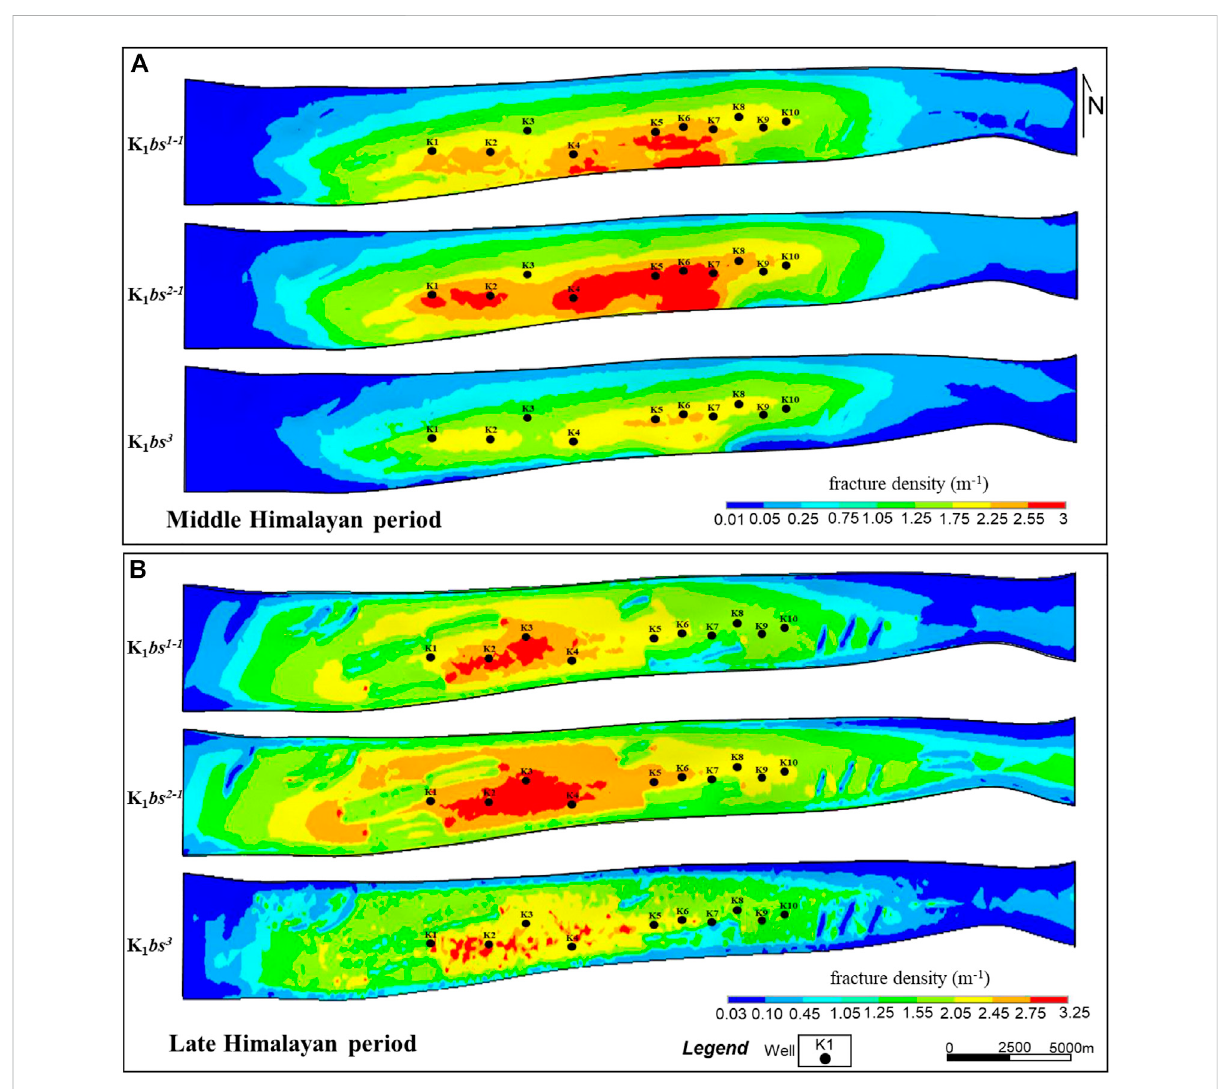
FIGURE 12 Spatial distribution offracture developmentdegreeindifferentperiod. (A) Fracturelinear density inMiddleHimalayan period; (B) Fracturelinear density in late Himalayan